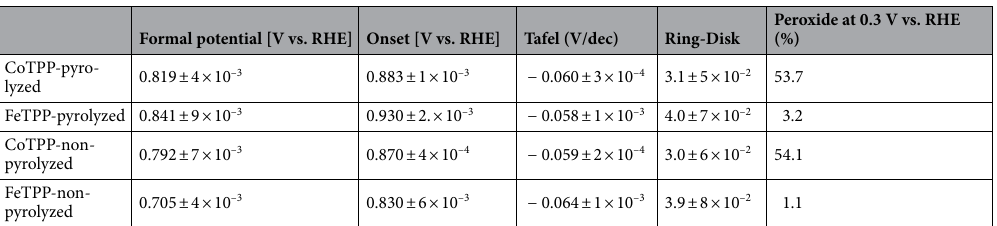
Table 2. Electrochemical parameter for pyrolyzed and non-pyrolyzed